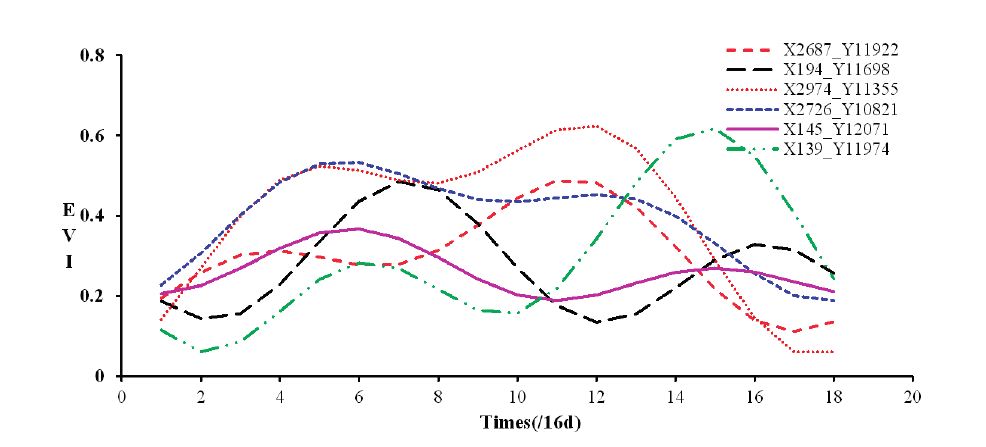
Figure 4. Cultivated land characteristic